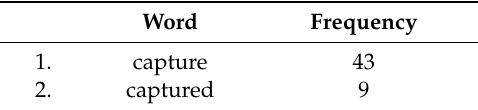
Table 1. List of words and